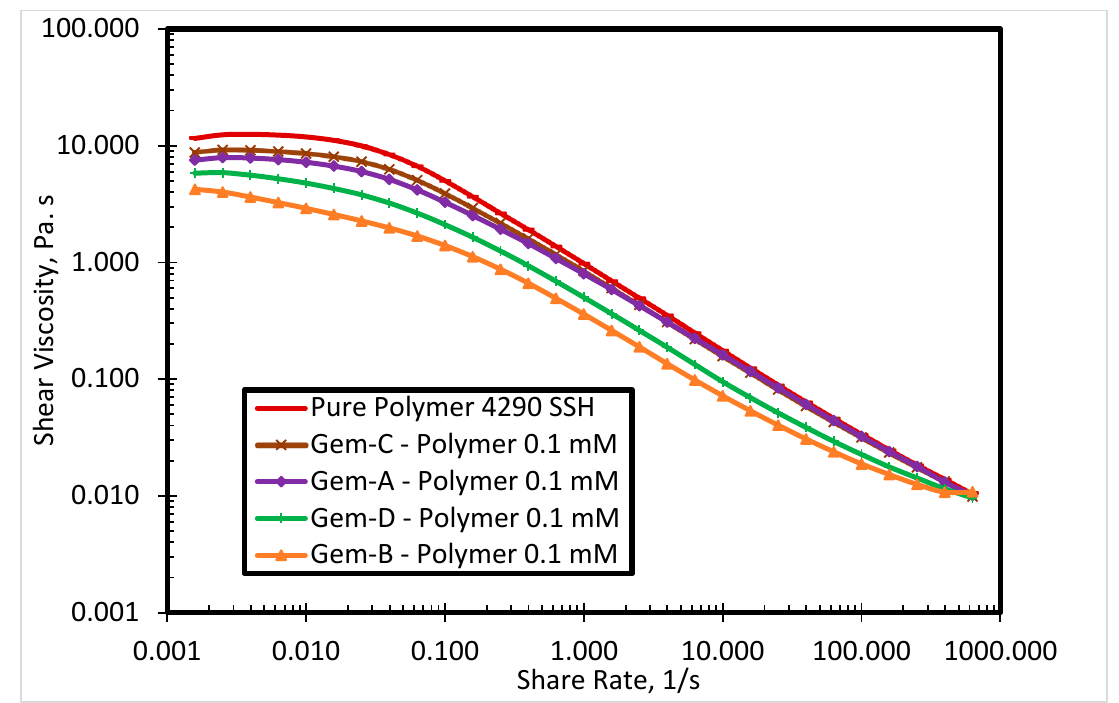
Figure 10. Shear viscosity of 4290 SSH polymer with all surfactants at 0.1 mM concentration.